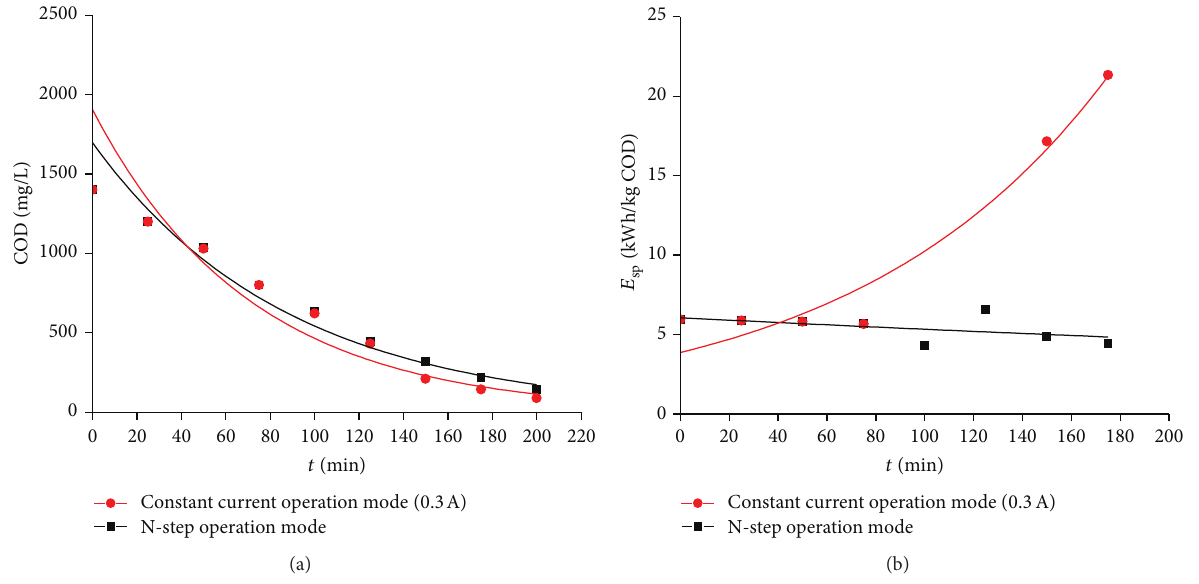
Figure 3: Variation of COD using different operating mode over time. (a) Variation of remaining COD concentration over time. (b) Power consumption using different operating mode over